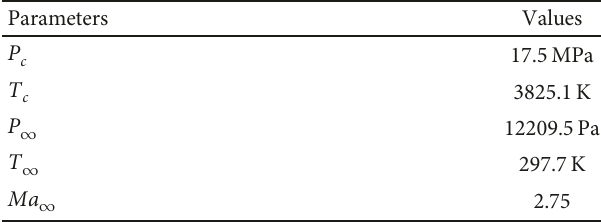
Table 2: Boundary conditions.